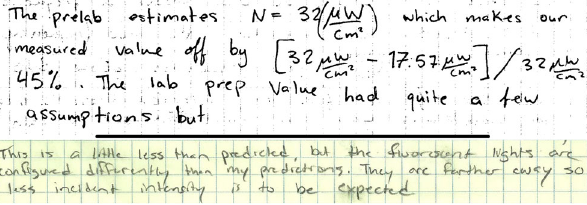
FIG. 8. Two examples of documented comparisons for Activity 2. The top example demonstrates a quantitative com- parison using percentage difference. The bottom example makes a subjective qualitative statement ( “ a little less than predicted ” ) as a